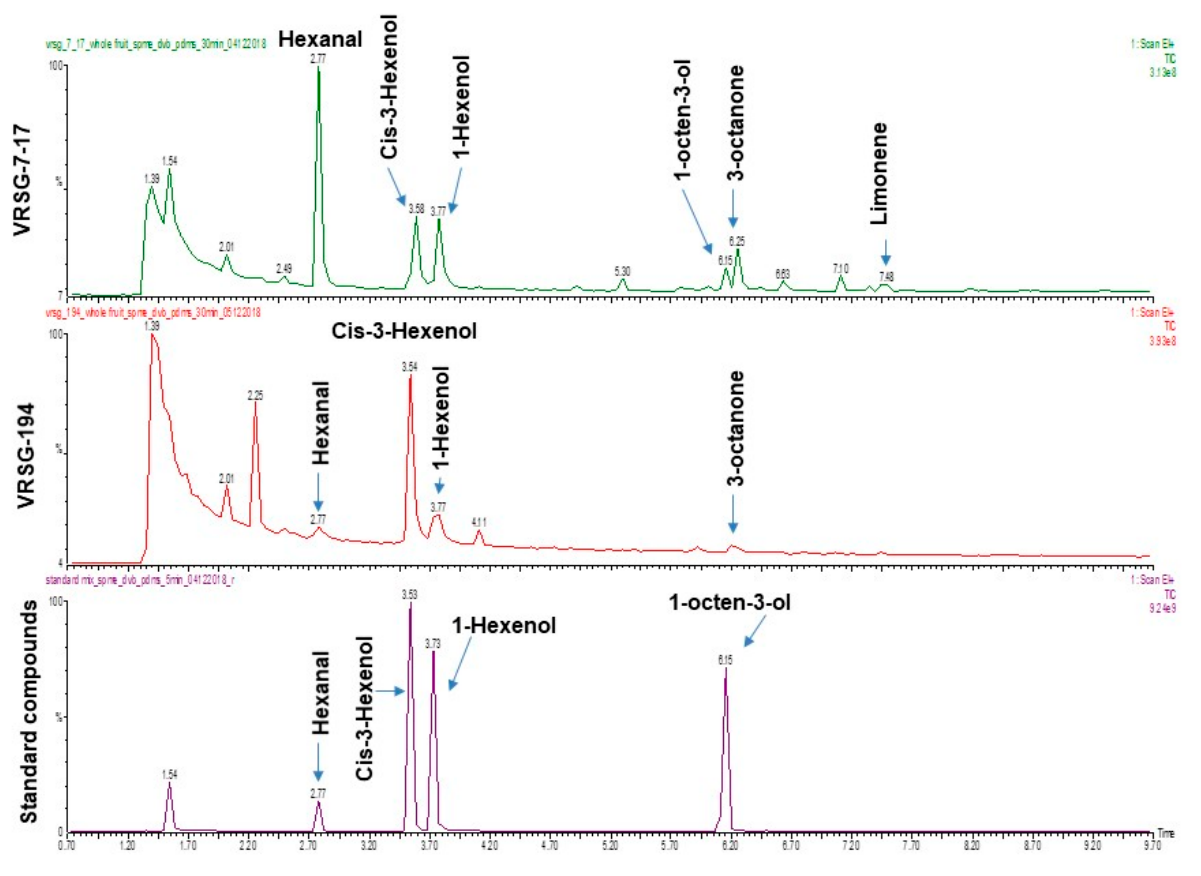
Figure 3. Typical GC–MS–SIM chromatograms of the extract obtained from the aromatic accession (VRSG-7-17) and VRSG-194 of sponge gourd along with the standard mix. The molecular formula of identified chemical compounds, e.g., (1) Hexanal (C 6 H 12 O); (2) Cis -3-Hexen-1-ol (C 6 H 12 O); (3) 1-Hexanol (C 6 H 14 O); (4) 1-Octen-3-ol (C 8 H 16 O); (5) 3-Octanone (C 8 H 16 O); (6) Limonene (C 10 H 16 O).